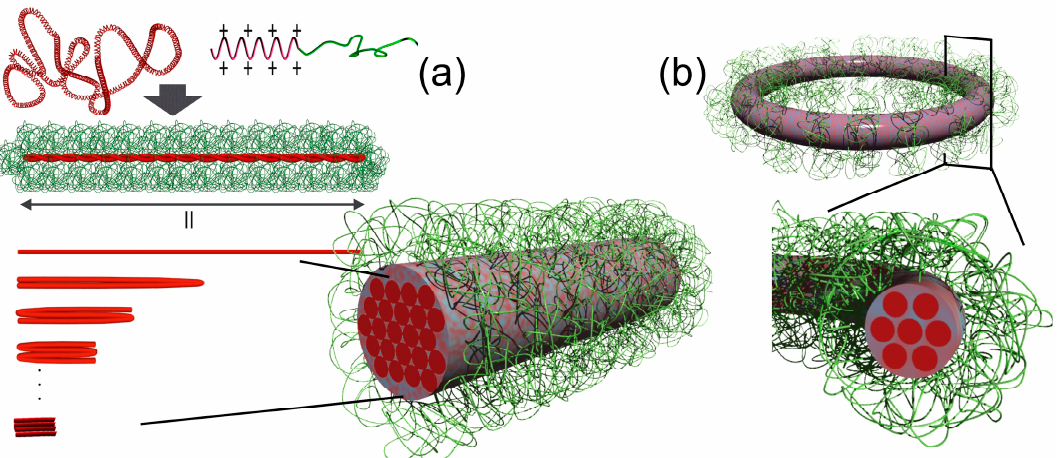
Figure 6. Specific folding scheme of pDNA induced by block copolymers. ( a ) A pDNA is folded into bundled-rod structure by quantized folding. ( b ) A pDNA is spooled into toroid. The toroid with bundled-rod structure by quantized folding. (b) A pDNA is spooled into toroid. The toroid with 6-spooled 6-spooled pDNA contains 7 packed DNAs within the pDNA contains 7 packed DNAs within the cross-section.